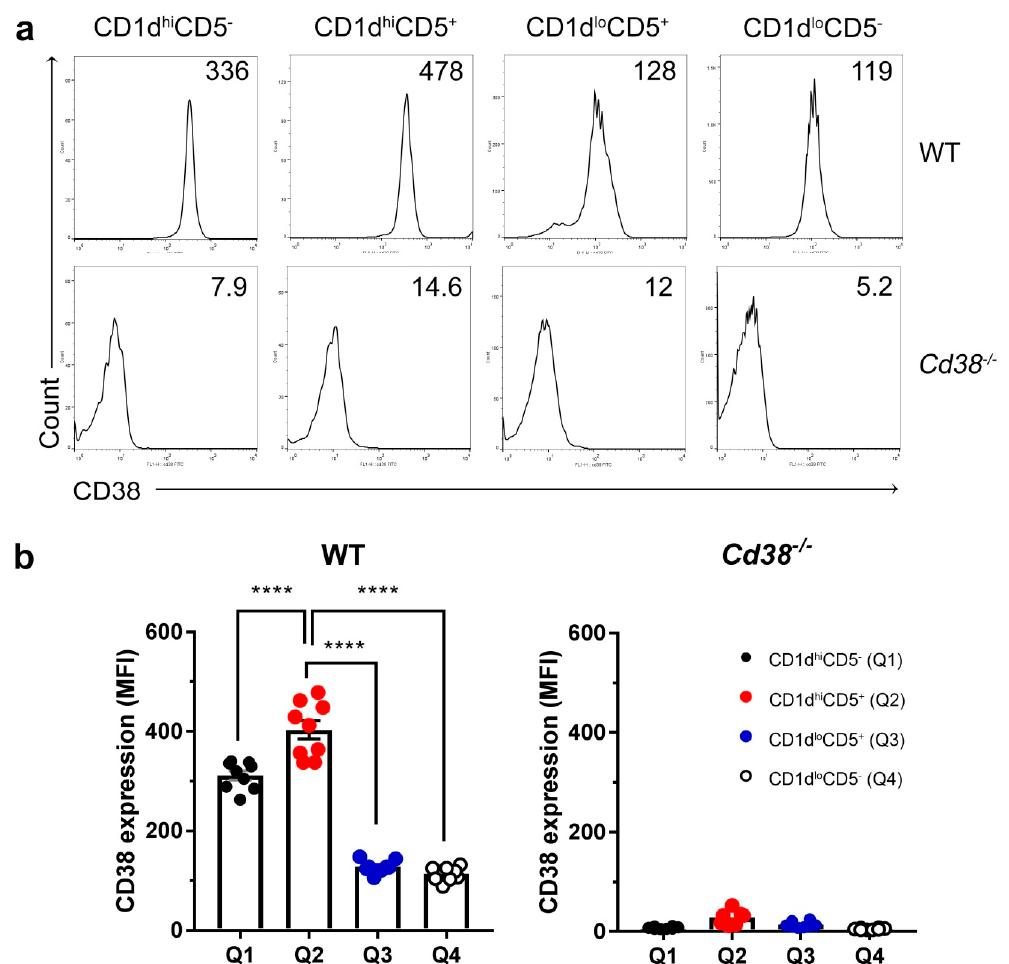
Figure 2. Increased surface expression of CD38 in WT CD1d hi CD5 + B cells. ( a ) Histograms represent CD38 expression determined by flow cytometry in each gated B cell subset from Figure 1a. Numbers within each panel represent the mean fluorescence intensities (MFI) for CD38 of a representative experiment performed in parallel in a naïve WT (upper panels) and in a naïve Cd38 − / − mouse. ( b ) Mean ± SEM of MFIs for CD38 expression in the four B cell subsets from spleens of WT and Cd38 − / − mice. Graph summarizes the results from nine independent experiments with a total of nine WT mice and eight Cd38 − / − mice. **** p < 0.0001; Ordinary One-Way ANOVA test corrected using Tukey’s multiple comparisons test.